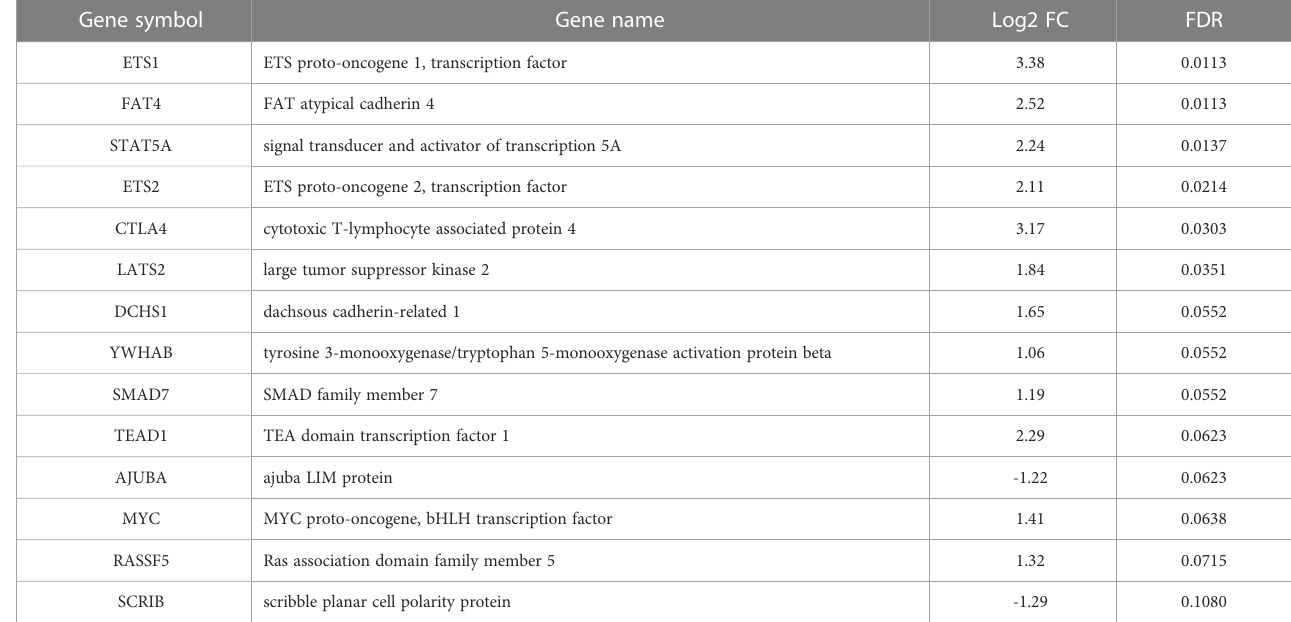
TABLE 4 Genes deregulated after adjuvant chemo-immunotherapy.